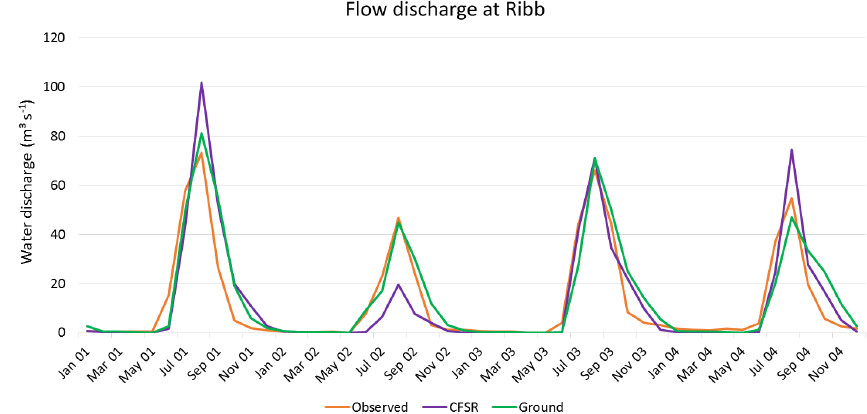
Figure 13. Flow discharge in the Ribb subcatchment. Calibration with outflow data achieved R 2 and NS values of the CFSR dataset: 0.81, 0.75; and ground dataset: 0.85, 0.83, respectively.